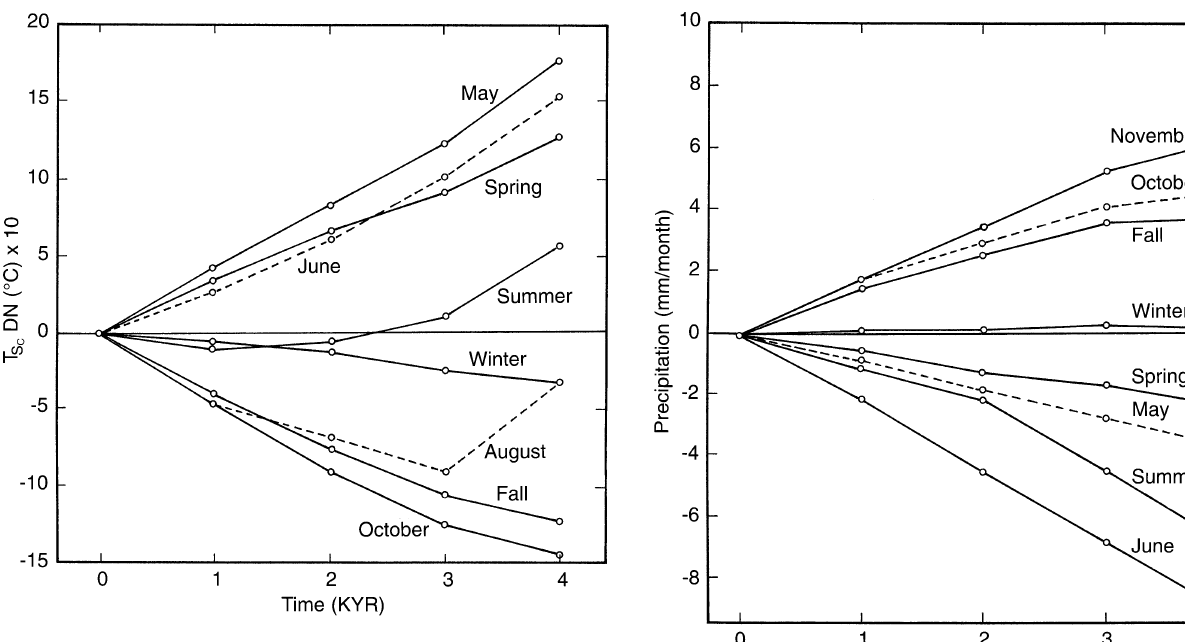
Fig. 8. Average values of continental ground temperature anomalies due to orbital variations, from present to 4 kyears AP (0.1 ° C)